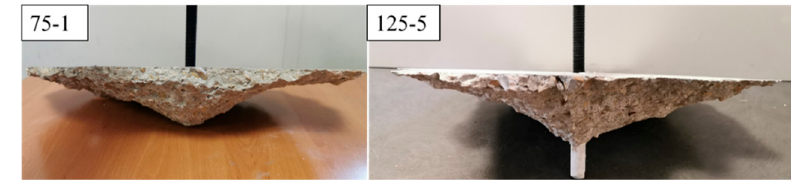
Figure 7. Typical crack patterns at ambient temperature.